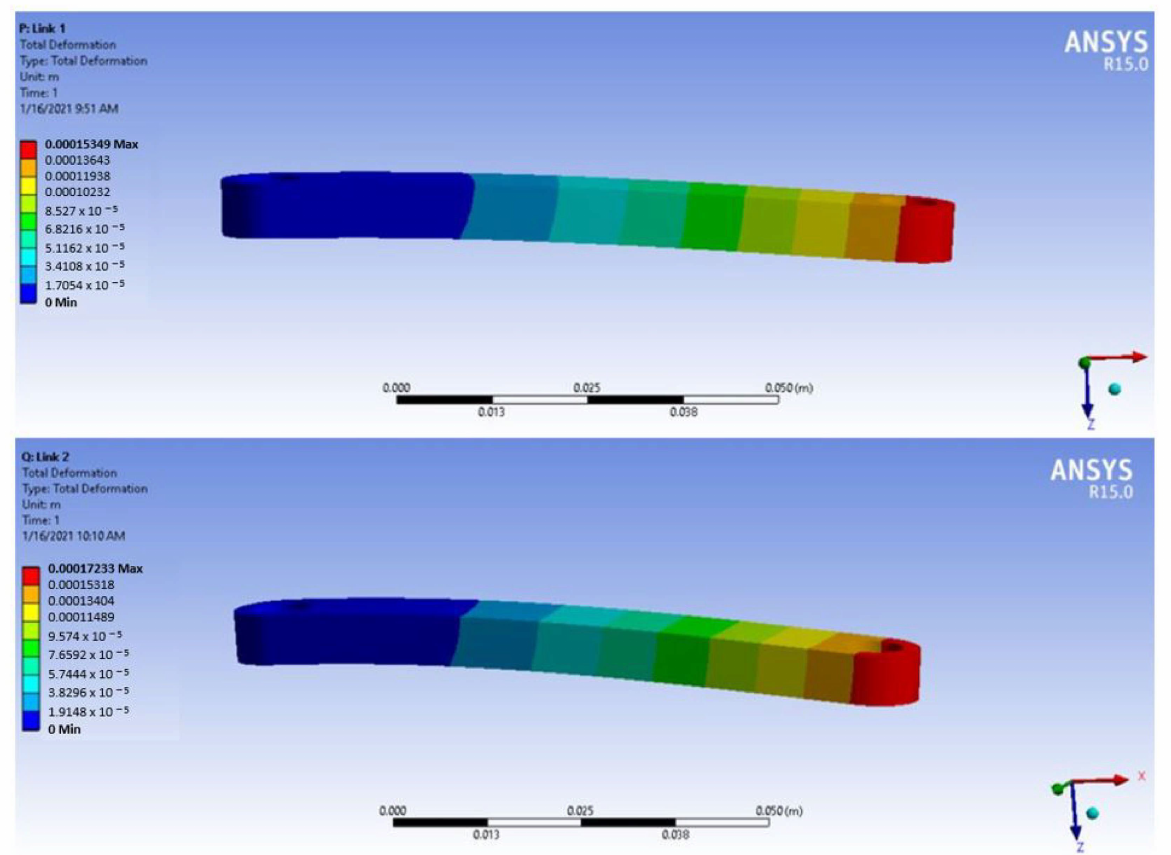
Figure 3. FEM analysis of both links using ANSYS Workbench